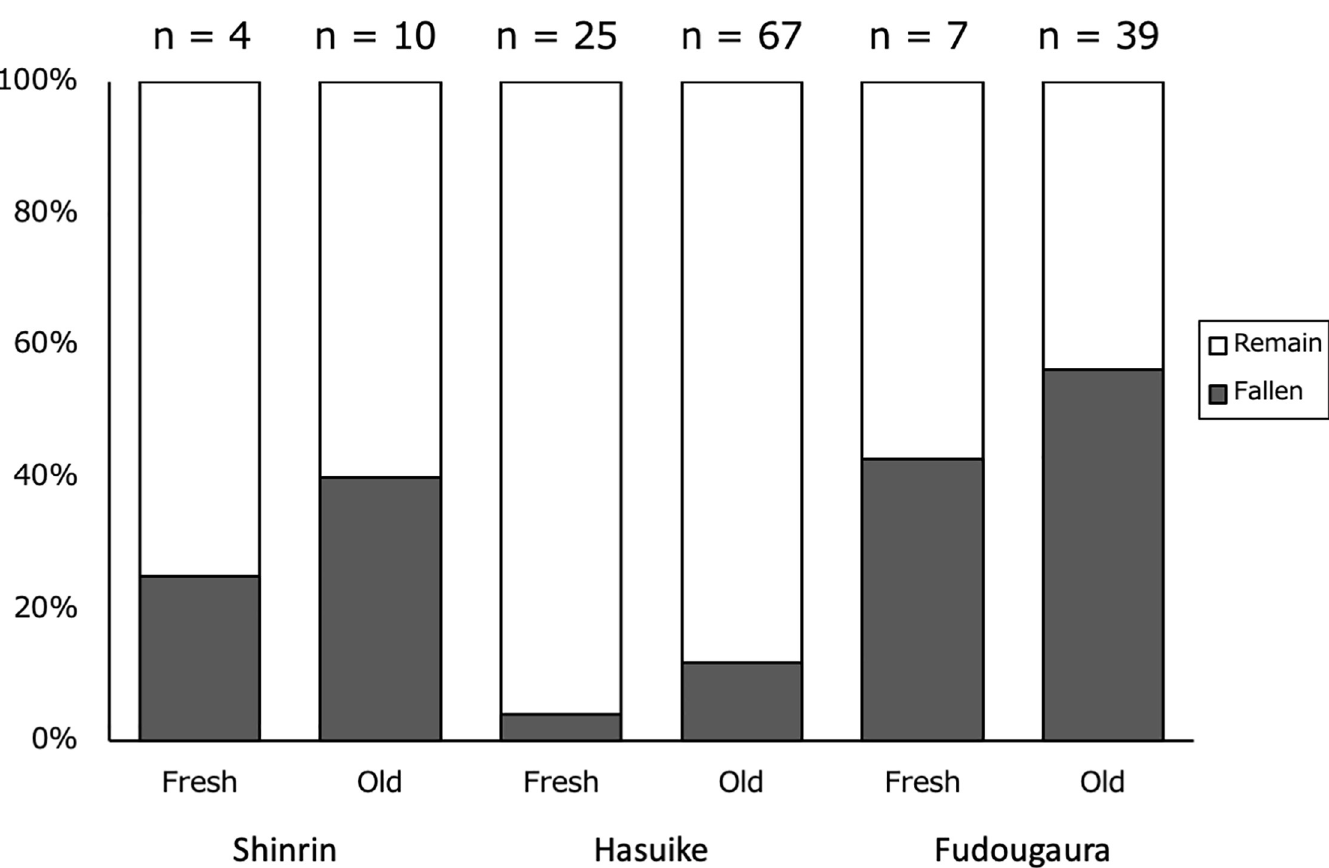
Fig 5. The number of eggs deposited in the field by A . bazalus , and that dropped from fresh and old L . edulis leaves in Shinrin Park and Hasuike Park (Hasuike), Saga, and Fudougaura, Fukuoka, Kyushu, Japan in